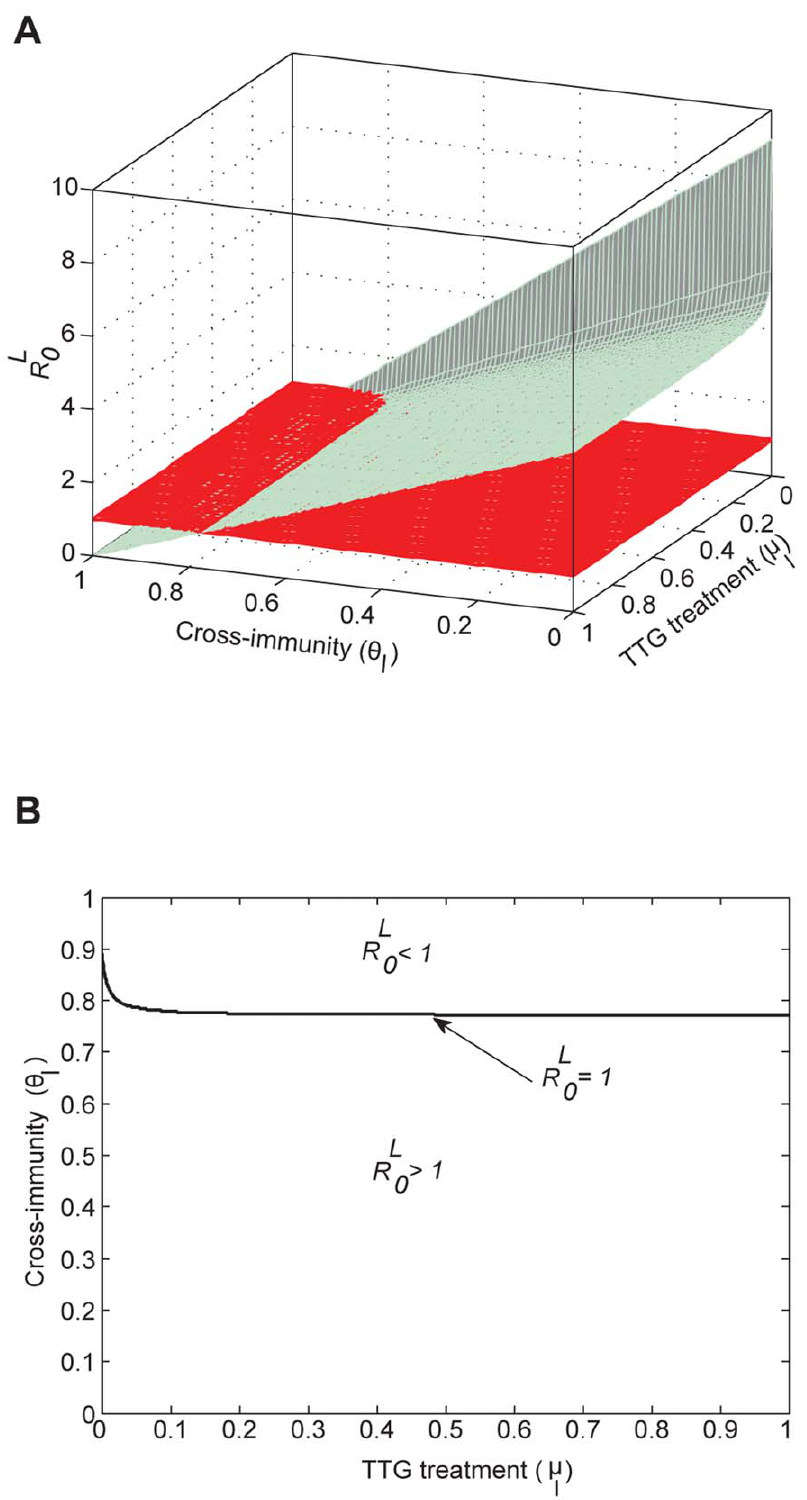
Figure 3. The effect of combined interventions, treatment and cross-immunity, in controlling outbreaks of TTG. (A) Different values of treatment ( m l ) and vaccine cross-immunity ( h l ) and basic reproductive number of TTG ( R L and progression of colonized individuals to infection is dependent on efficacy of cross-immunity ( h l ). (B) Critical combined intervention values required to stop TTG outbreak. Minimal treatment efficacy ( , 30%) and 77% cross-immunity are required to stop TTG outbreak ( R L